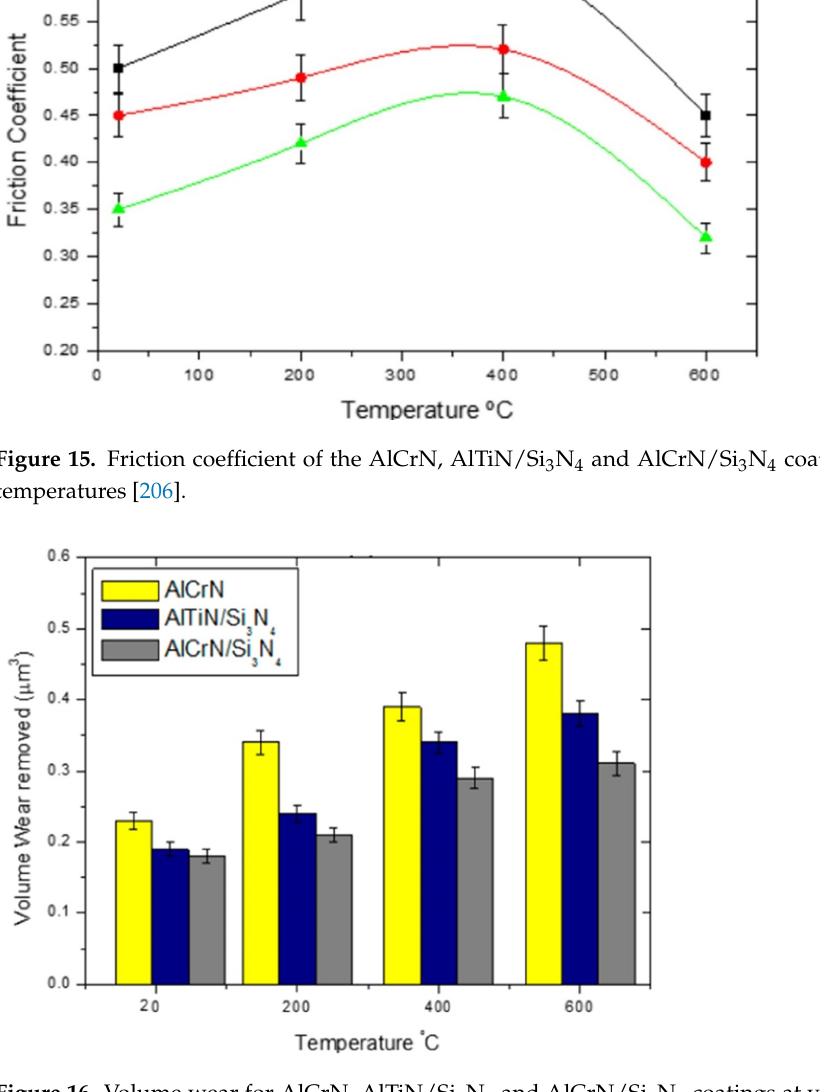
Figure 17. Number of parts produced by high-pressure die casting (HPDC) until defected parts are produced [206].